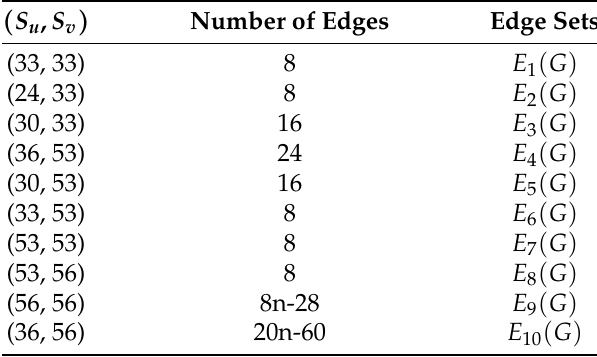
Table 2. Degree-based partition of edges of FCC ( n ) , for n ≥